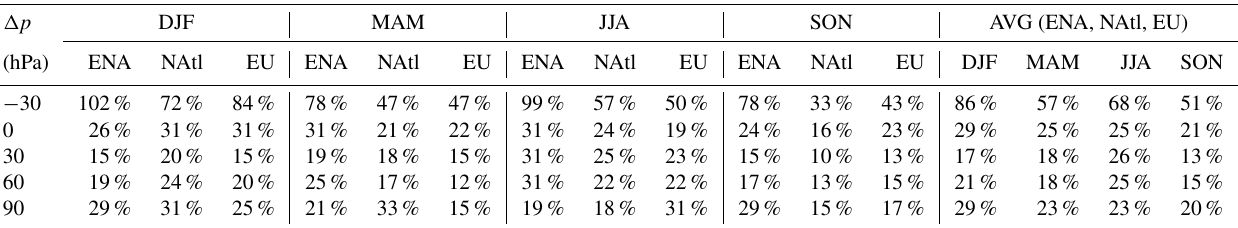
Table 2. ISSR frequency of occurrence: normalized standard deviations of seasonal mean values are reported in percentages, and the vertical distance to the thermal tropopause is reported as (cid:49)p = p layer − p therm.TPH .